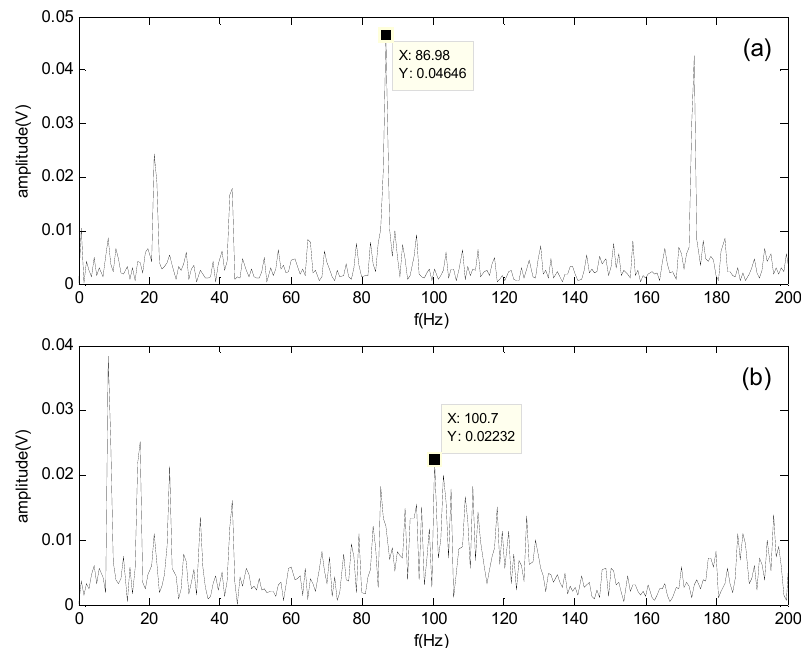
( a ) Spectrum of the outer-race defect; ( b ) Spectrum of the roller defect.